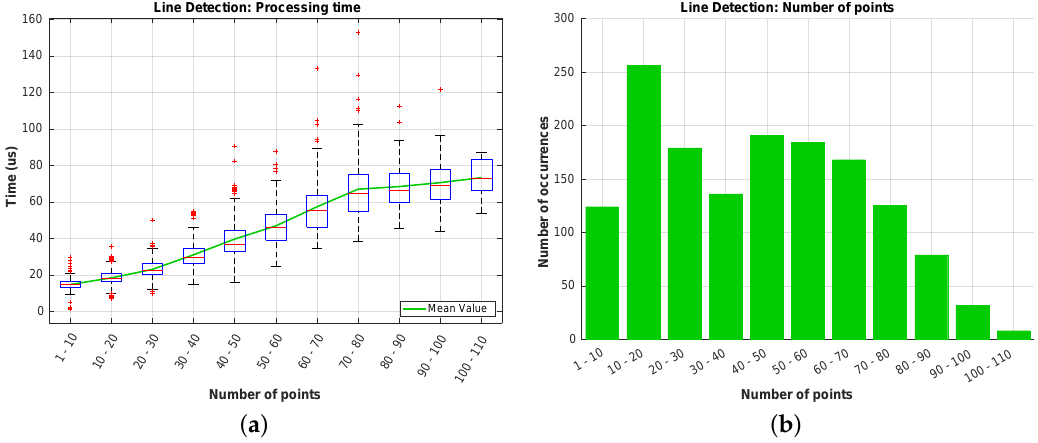
Figure 21. Processing time ( a ) and number of points occurrences ( b ) in the line